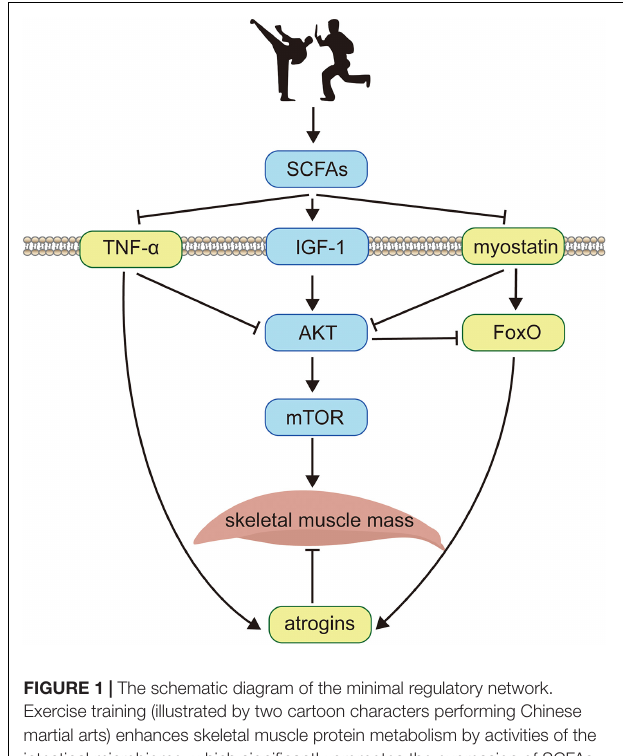
FIGURE 1 | The schematic diagram of the minimal regulatory network. Exercise training (illustrated by two cartoon characters performing Chinese martial arts) enhances skeletal muscle protein metabolism by activities of the intestinal microbiome, which significantly promotes the expression of SCFAs ( u SCFAs ) . Meanwhile, SCFAs increase the concentration of membrane receptor IGF-1 that recruits the phosphorylation of AKT ( u AKT ) and positively regulates mTOR ( u mTOR ), which is deemed as the downstream target of AKT. On the other hand, SCFAs inhibit TNF − α ( u TNF − α ) which is a membrane-bound inflammatory cytokine produced by macrophages and myostatin ( u myo ) which is a growth factor controlling muscle fibers. Both TNF- α and myostatin deactivate the phosphorylation of AKT, enhancing the expression of atrogins ( u atr ) through ubiquitin-proteasome system and autophagy-lysosome pathways via the transcription factor FoxO ( u FoxO ), which is related with the apoptosis during muscle fibers metabolism and is suppressed by AKT. The skeletal muscle mass ( u muscle ) is balanced by synthesis and degradation processes, with the former activated by mTOR and the latter inhibited by atrogins. Black solid arrows indicate positive feedbacks between protein interactions, and negative feedbacks are denoted by (cid:97) .